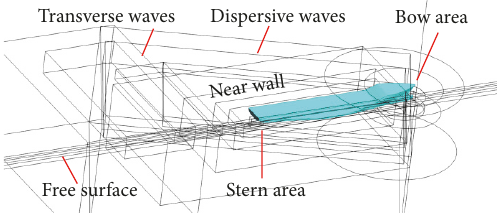
Figure 3: Multiple blocks for improving mesh resolutions to resolve vortices and waves.